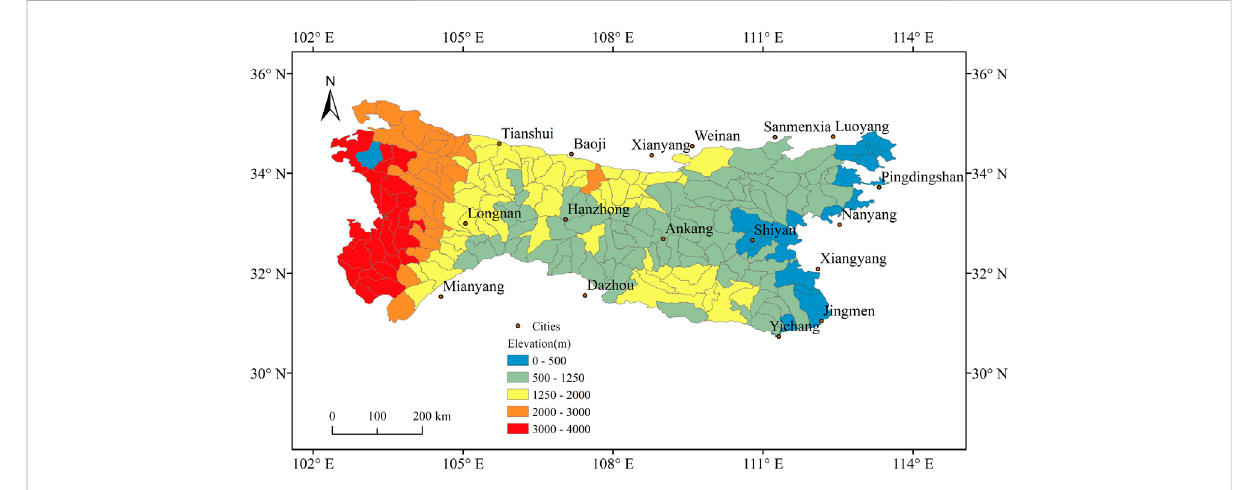
FIGURE 7 Average altitude of each catchment in the Qinling-Daba Mountains.